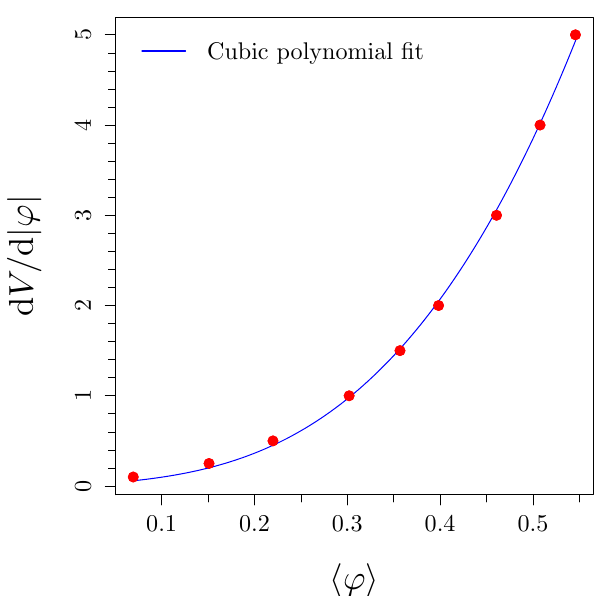
Figure 5. Derivative of the effective potential with respect to | ϕ | as a function of h ϕ i . The existing statistical errors on h ϕ i are too small to be visible. The blue curve corresponds to a cubic polynomial fit with eq.